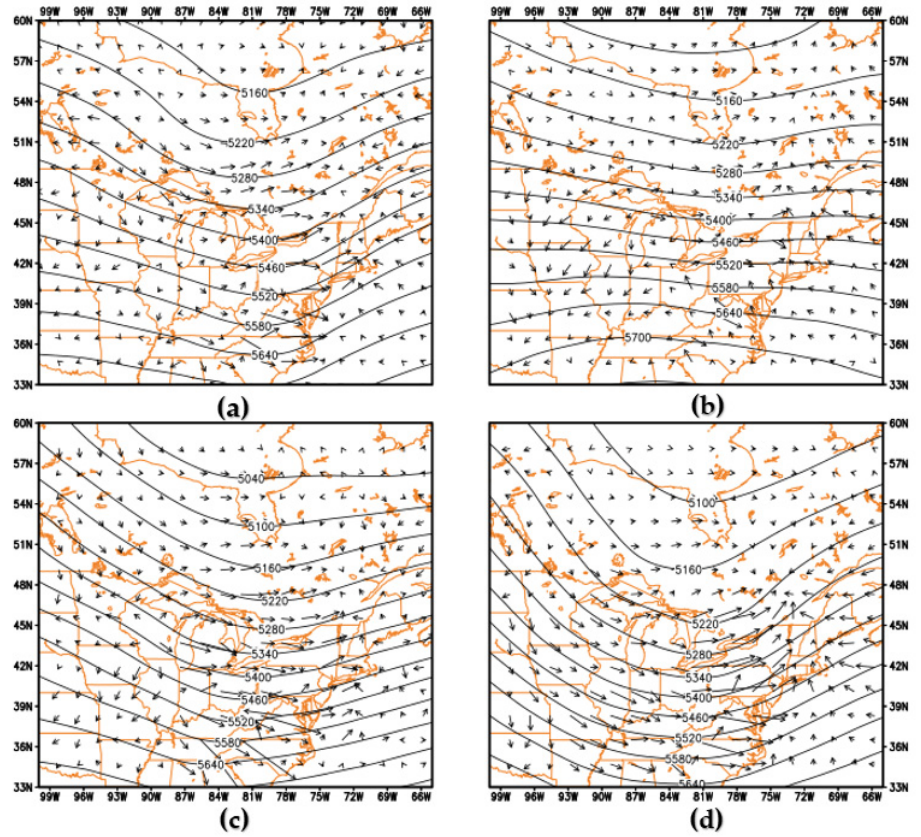
Figure 8. 500 mb geopotential heights (m; contours) and Q-vectors for Cluster 1 ( a ), Cluster 2 ( b ), Cluster 3 ( c ), and the LES composite ( d ) while the clipper was located at 75° W.